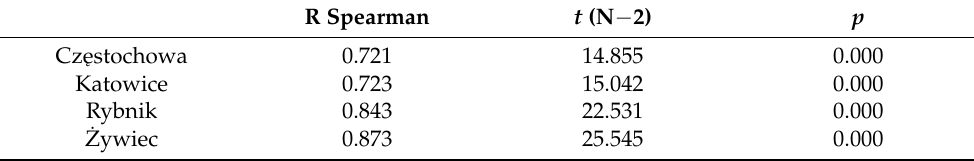
R Spearman—correlation coefficient, p —significance level, t —significance test result for correlation coefficient.